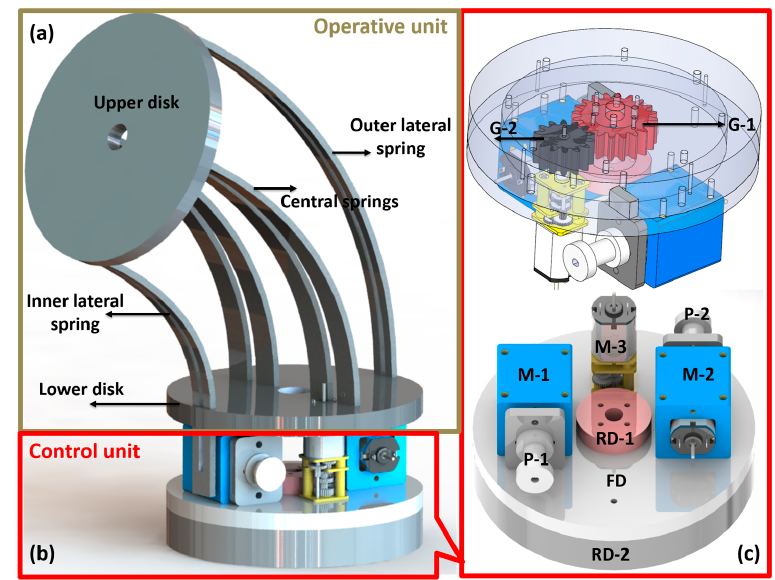
Figure 2. Design of SIMBA’s basic module. ( a ) Operative unit; ( b ) control unit; ( c ) details of the control unit. RD ‐ 1= upper rotational disk 1; RD ‐ 2 = bottom rotational disk 1; P ‐ 1 = pulley for motor 1; P ‐ 2 = pulley for motor 2; FD = fixed disk for motor fixing; M ‐ 1 = motor bending; M ‐ 2 = motor stiffening; M ‐ 3 = motor for rotation; G ‐ 2 = driving gear connected to M ‐ 3; G ‐ 1 = pinion gear fixed on RD ‐ 2.